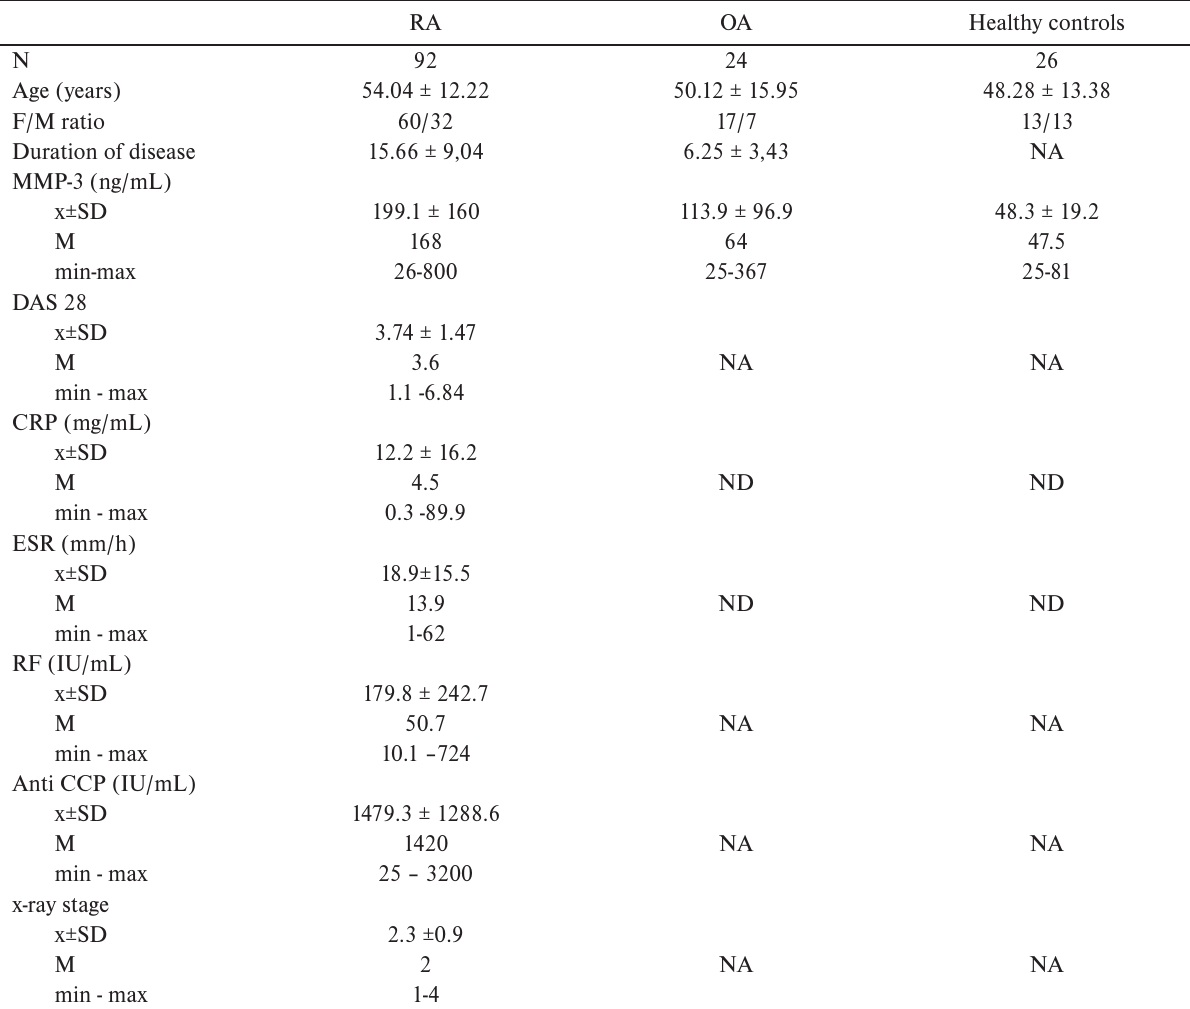
Table 1. Demographic data and results of MMP 3 measurement in RA, OA groups and in healthy controls and activity, labora- tory and radiographic profile of RA